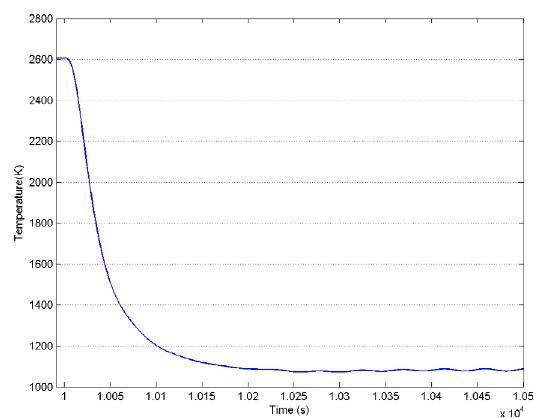
Fig. 10. Power (3D).